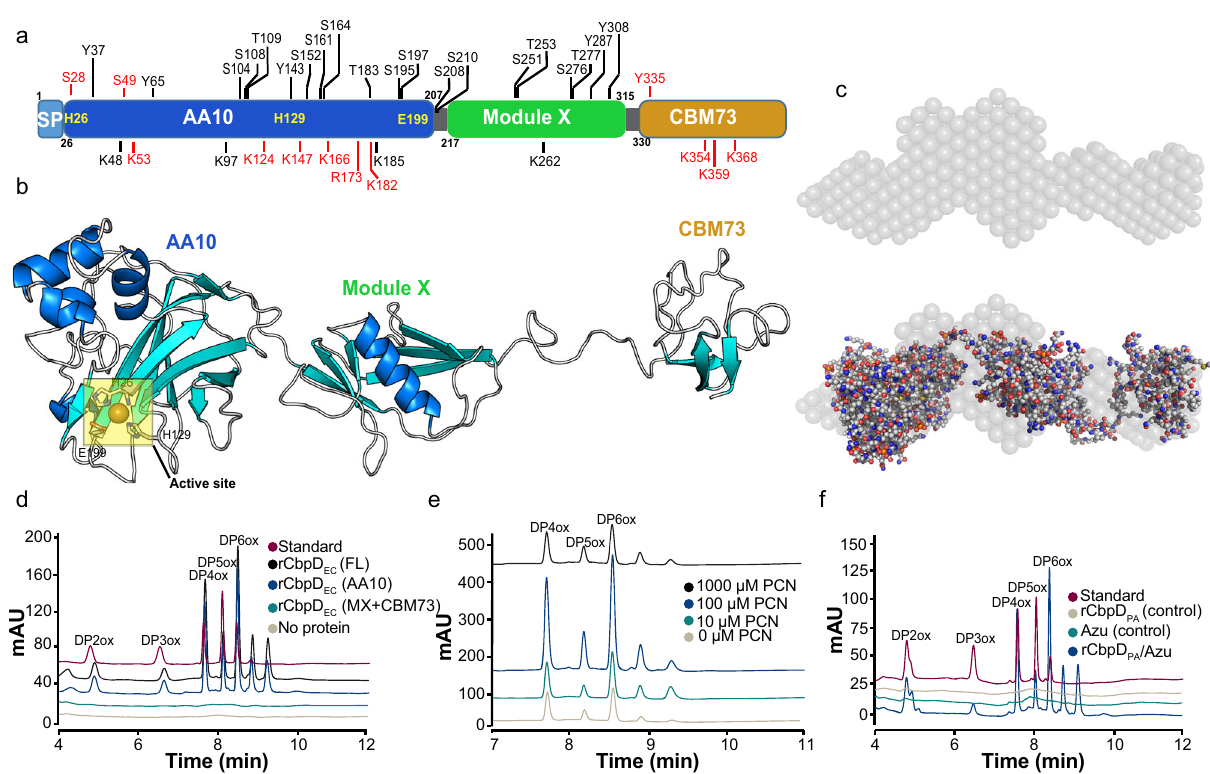
Fig. 1 Multidomain structure of CbpD and evaluation of its activity on a model substrate. a Schematic representation of the domain architecture of CbpD. The full-length protein contains a signal peptide (SP), an N-terminal AA10-type LPMO domain (AA10) followed by a module with unknown function (module X or MX) and a C-terminal CBM domain (CBM73). The residue boundaries for each domain, as well as potential post-translational modi fi cation (PTM) sites based on refs. 25,35,36 and Supplementary Table 1, are labeled; phosphorylation sites are indicated above and lysine/arginine modi fi cations below the domain illustration. PTMs identi fi ed in this study (Supplementary Table 1) are colored red. b Homology model of CbpD generated with Raptor- X 92 showing fl exible linkers in an extended conformation. The active site is indicated by a yellow partially transparent square. c SAXS model of monomeric CbpD ( χ 2 = 2.35; produced with Pepsi-SAXS 114 ; SASBDB ID: SASDK42), superimposed onto the ab initio SAXS model “ envelope ” (produced with DAMMIF 111,112 based on an average of 20 calculated models). Panels b and c were generated using PyMol. d Product formation by 1 µ M of rCbpD EC variants (FL: full-length; AA10: AA10 module only; MX + CBM73: the MX and CBM73 domains only) after a 2 h reaction at 37 °C with 10 mg ml − 1 β -chitin in 20 mM Tris-HCL pH 7.0, with 1 mM ascorbate as reducing agent, analyzed by HILIC. The degrees of polymerization (DP) of oxidized chitooligosaccharide aldonic acids in a standard sample are indicated. Control reactions without ascorbate did not show product formation. e HILIC analysis of reaction products emerging from a reaction of 1 µ M rCbpD EC with 10 mg ml − 1 β -chitin, 250 µ M ascorbate in 20 mM Tris-HCl pH 7.0, and serial dilutions of pyocyanin (PCN) for 2 h at 37 °C. The chromatograms have been offset on the y axis to enable visual interpretation of their quantitative magnitude. Chromatograms for reactions containing serial dilutions of PCN and with or without various reductants that were sampled at different time points are shown in Supplementary Fig. 7c. f HILIC analysis of reaction products emerging from a reaction of 1 μ M of copper-free full-length rCbpD PA with 10 mg ml − 1 β -chitin in 20 mM Tris- HCL pH 7.0, 100 µ M pyocyanin (PCN), 250 µ M ascorbate, in the presence or absence of 1 µ M azurin (Azu) after incubation for 2 h at 37 °C. Control reactions without added ascorbate did not show product formation (Supplementary Fig.